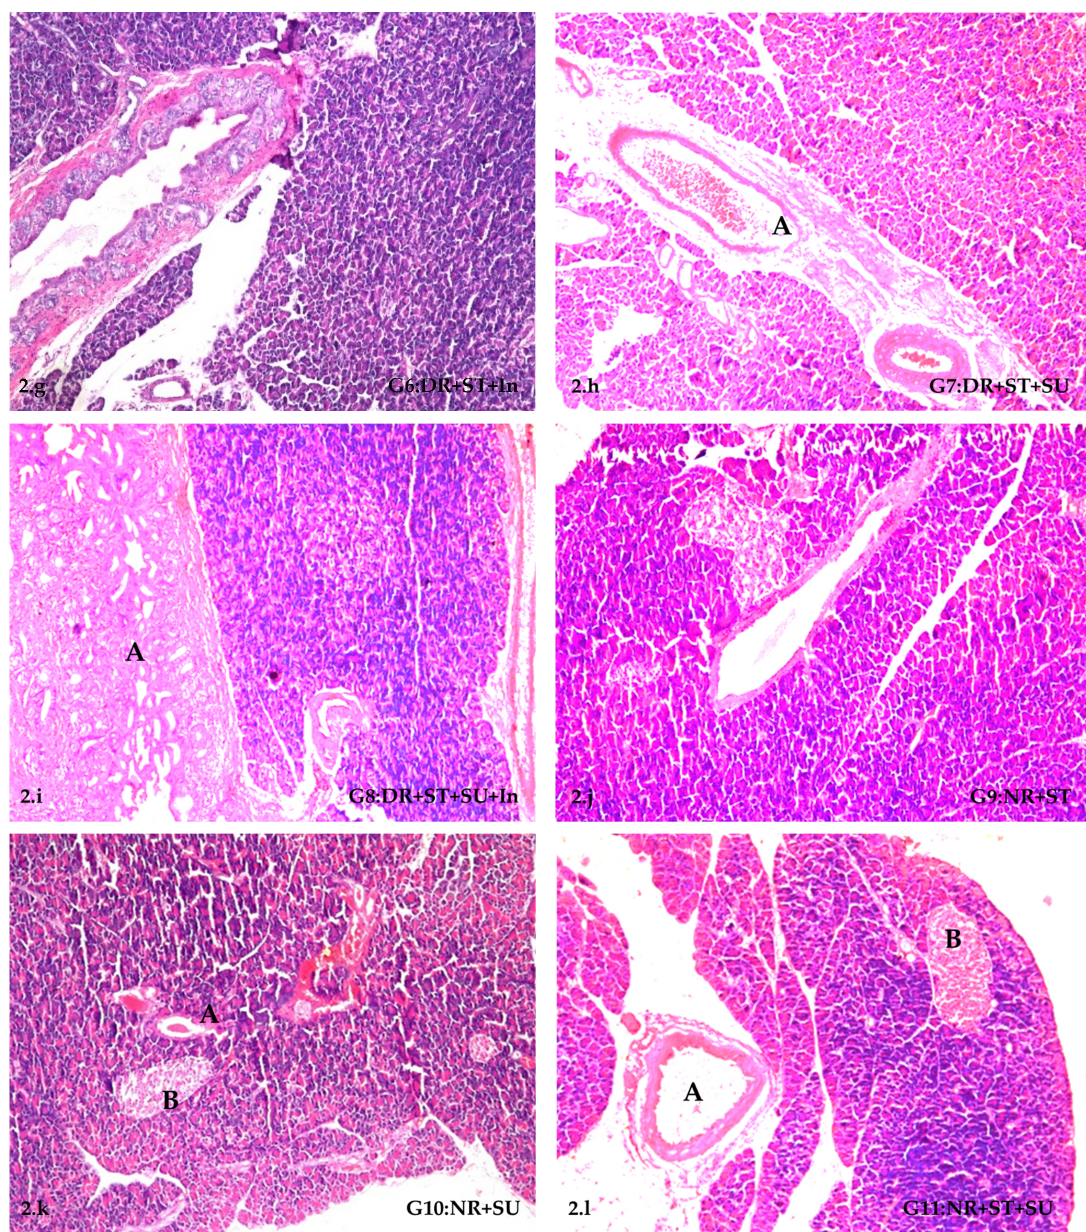
Figure 2. The histopathological structure in pancreatic tissues of STZ-induced diabetes in rats (H&E, X160). ( a ) Pancreas of a rat from G1 (NR) showing a typical histological structure of the islets of Langerhans (A) and the exocrine acinar and ductal system (B). ( b ) Pancreas of a rat from G2 showing complete atrophy of the islets of Langerhans (A) and ( c ) showing ductal hyperplasia (A) with newly formed ductules (B). ( d ) Pancreas of a rat from G3 showing atrophy of islets of Langerhans (A) with newly formed ductules (B). ( e ) Pancreas of a rat from G4 showing atrophy of islets of Langerhans (A) and depletion of its cells with hyperplasia of the ductal epithelium (B). ( f ) Pancreas of a rat from G5 showing mild atrophy with a degenerative change in the Langerhans cells (A). ( g ) Pancreas of a rat from G6 showing standard histological criteria. ( h ) Pancreas of a rat from G7 showing congestion in the stromal blood vessels (A). ( i ) Pancreas of a rat from G8 showing numerous newly formed ductules within a thickened stroma (A). ( j ) Pancreas of a rat from G9 showing a typical histological structure. ( k ) Pancreas of a rat from G10 showing congestion (A) and mild atrophy of pancreatic islets (B). ( l ) Pancreas of a rat from G11 showing dilatation in a stromal blood vessel (A) but the typical histological structure of the islands